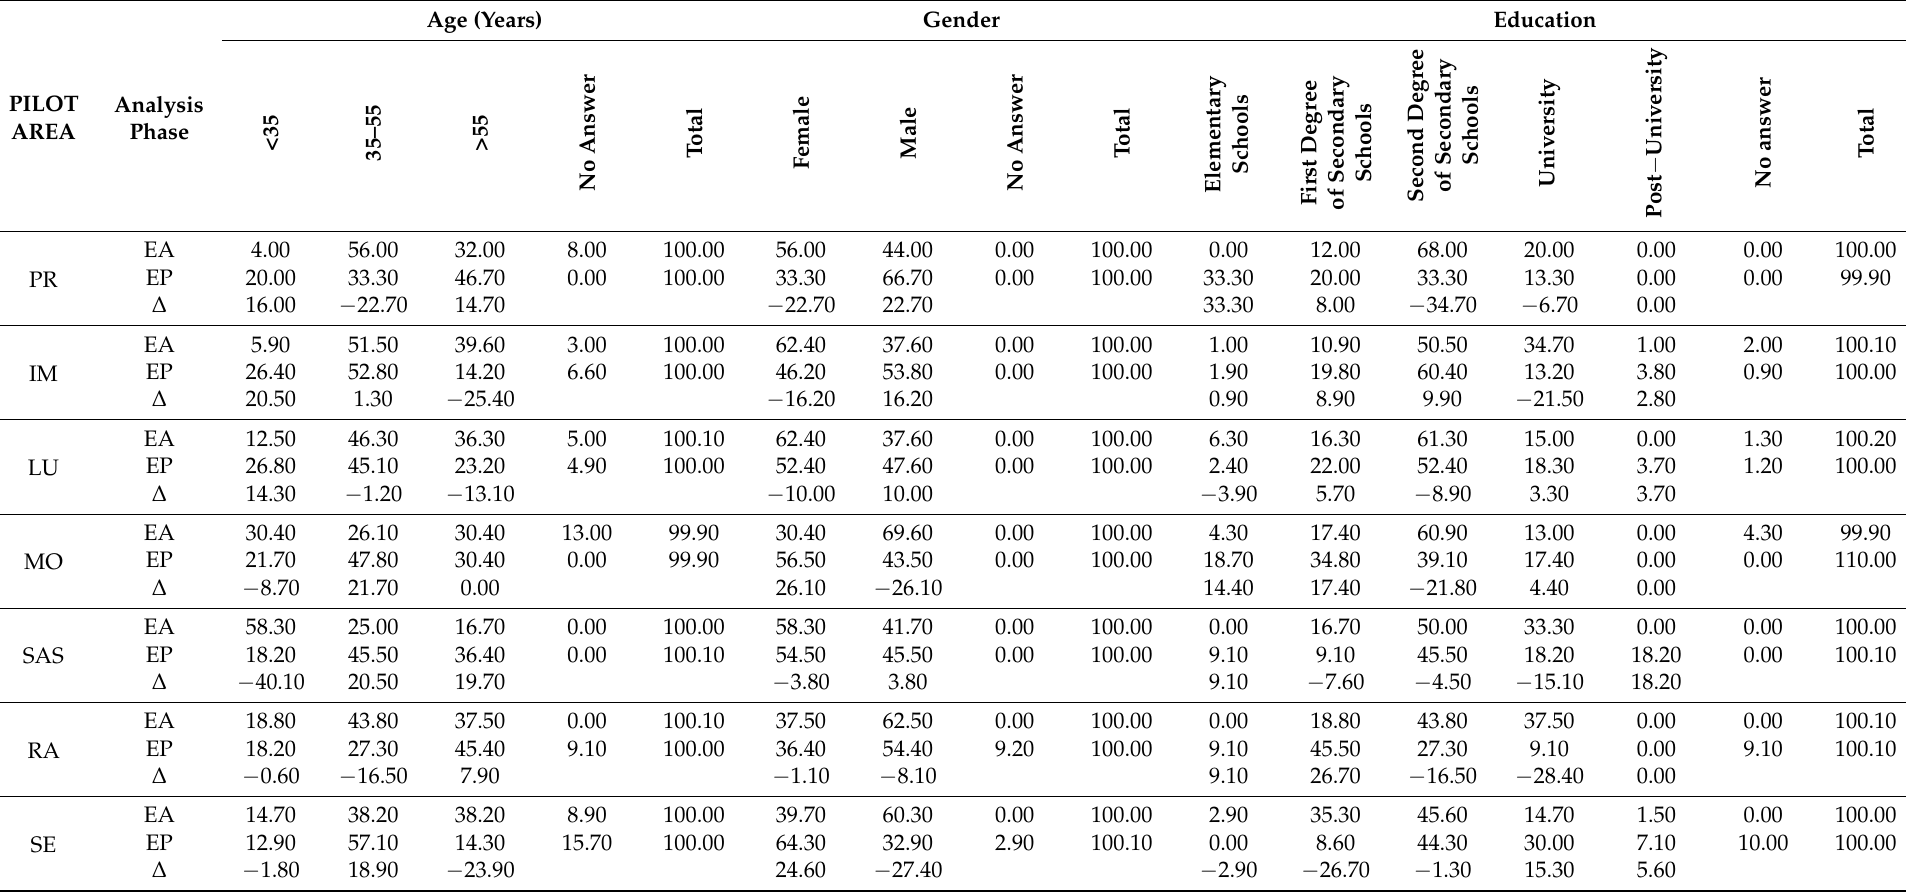
Table A1. Demographic information (age, gender, and education in percentages) about the participants in the ex-ante (EA) and ex-post (EP) phases with the difference between the two phases ( ∆